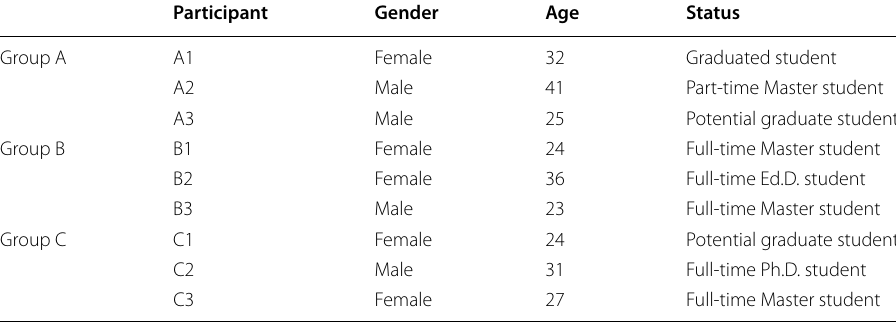
Table 1 Participant